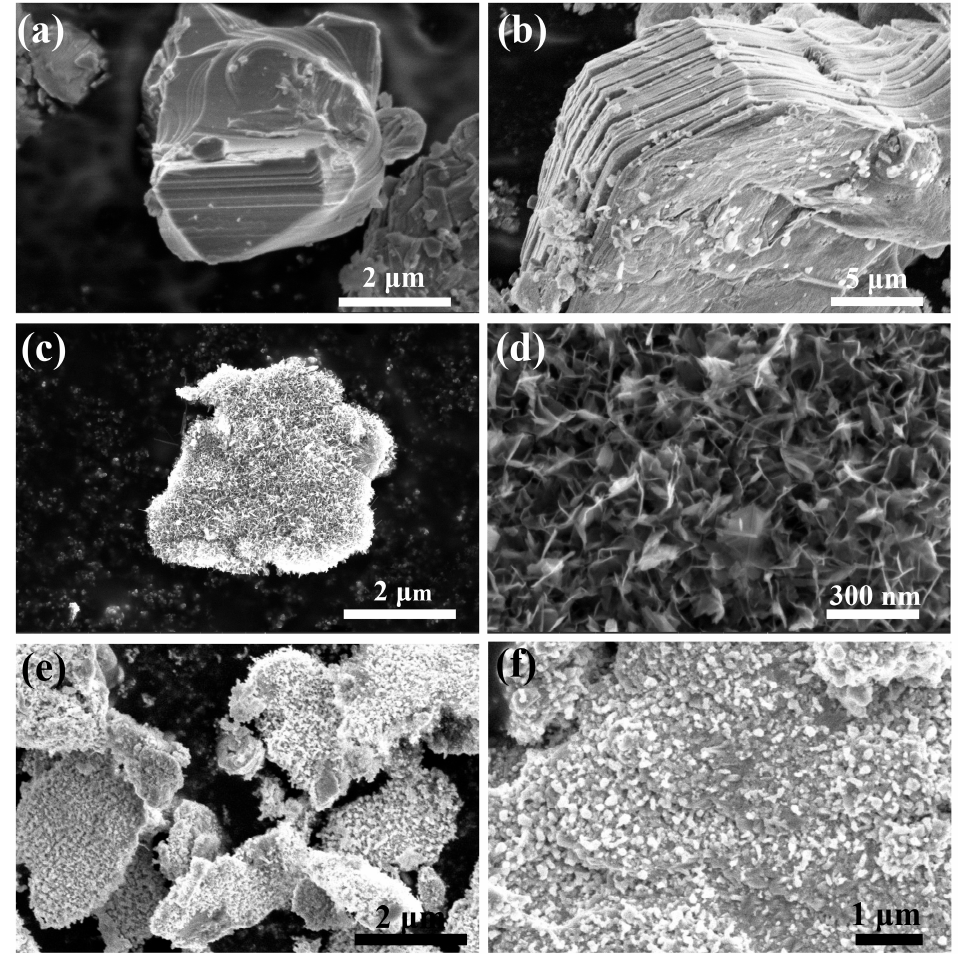
Figure 2. SEM images of ( a ) Ti 3 AlC 2 MAX, ( b ) MXene/ Ni; ( c , d ) C-N polymer@NiFe LDH@MXene/Ni; ( e , f ) C-N@NM.